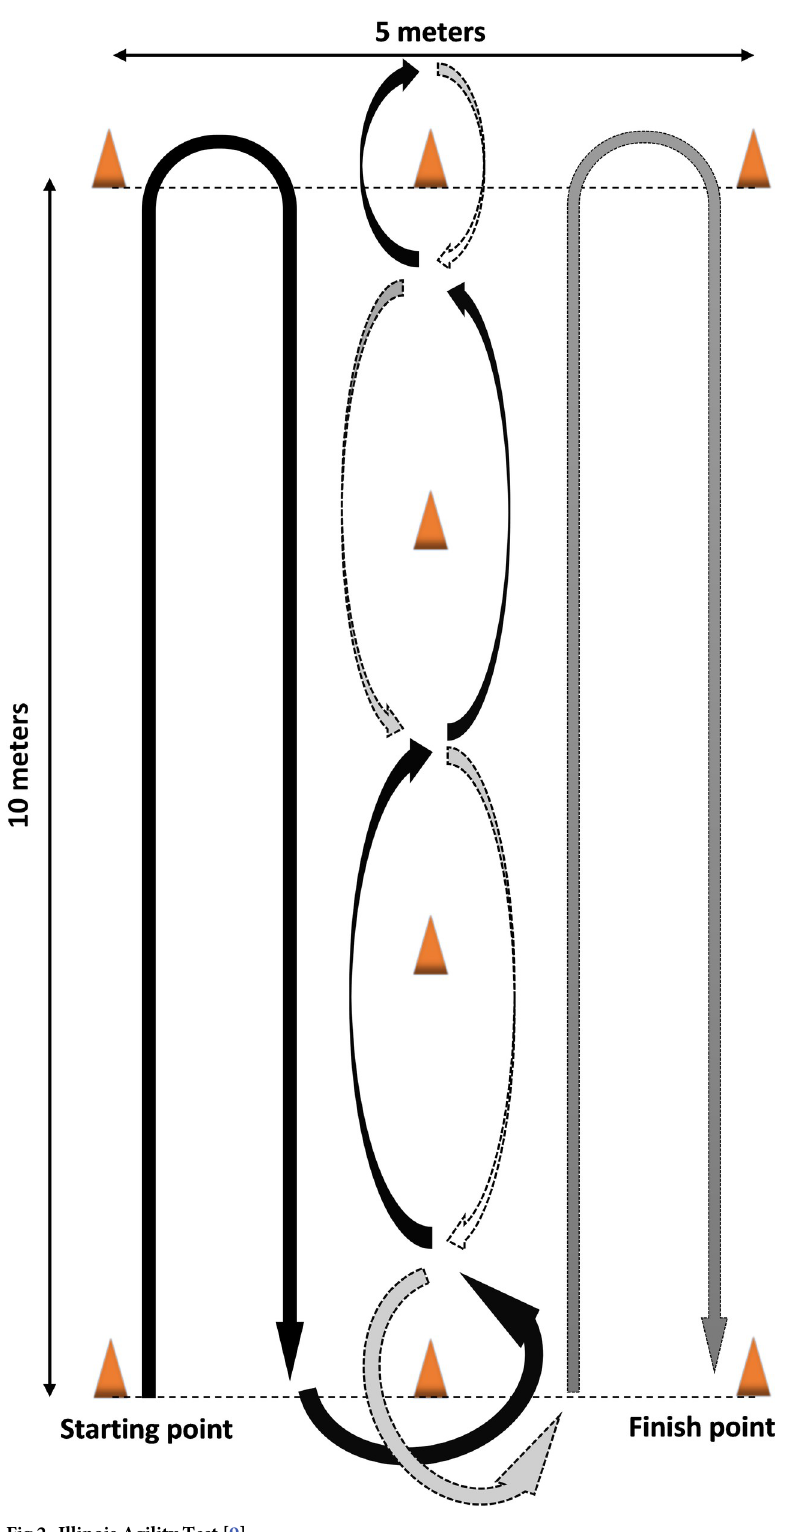
Fig 2. Illinois Agility Test